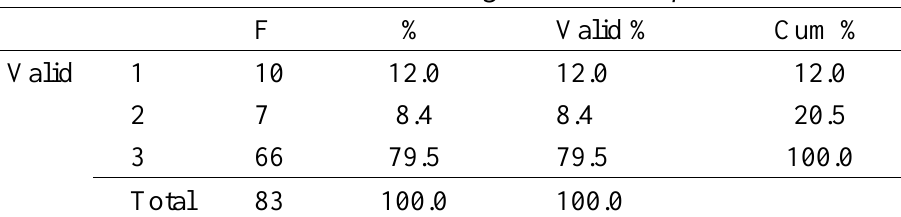
Tabel 5. P2. Pengaksesan